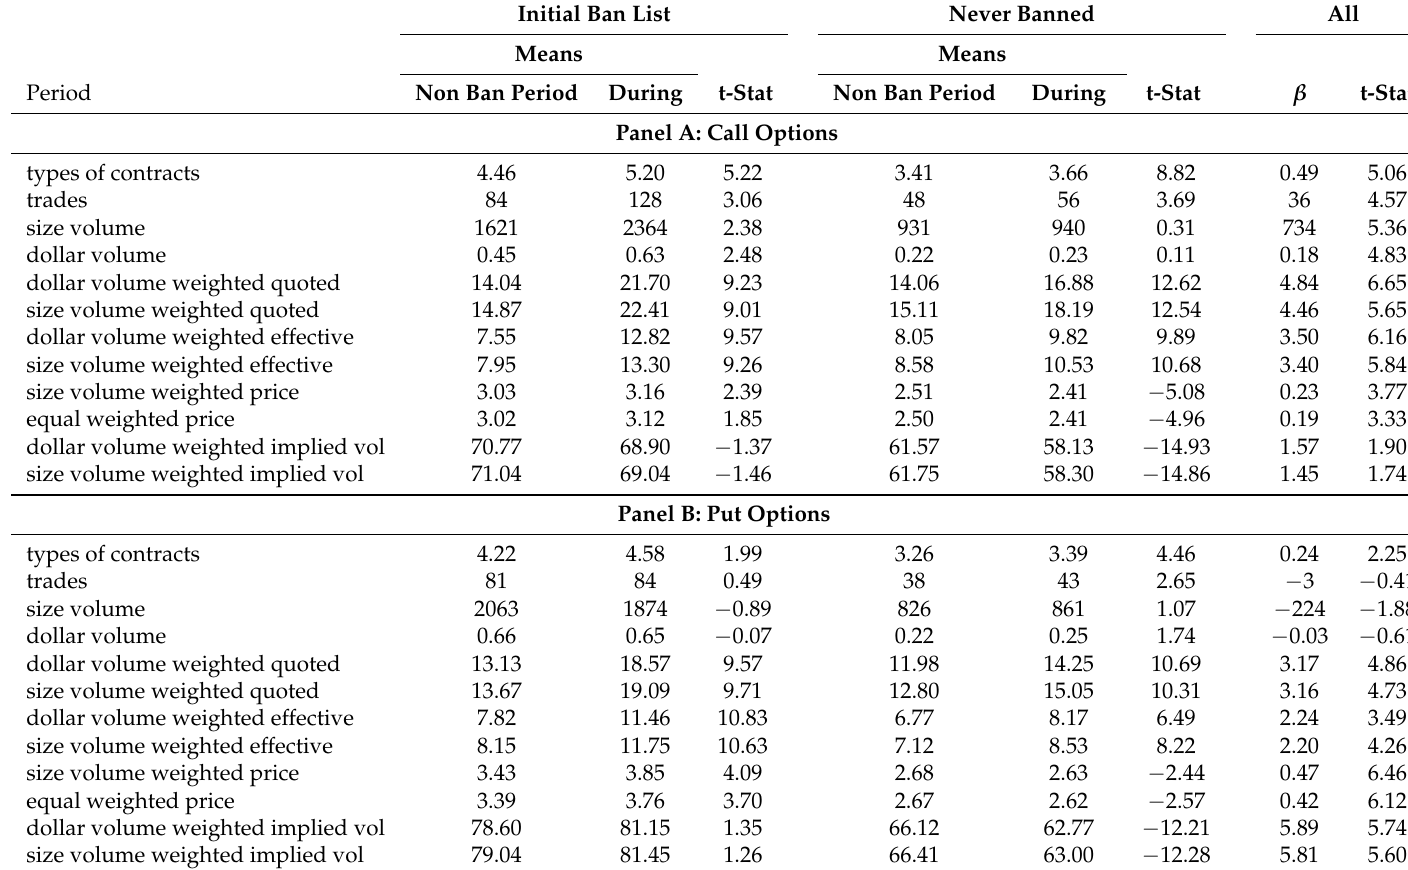
Table 4. Cross sectional means and t-statistics for option trade summary statistics: Out of the money